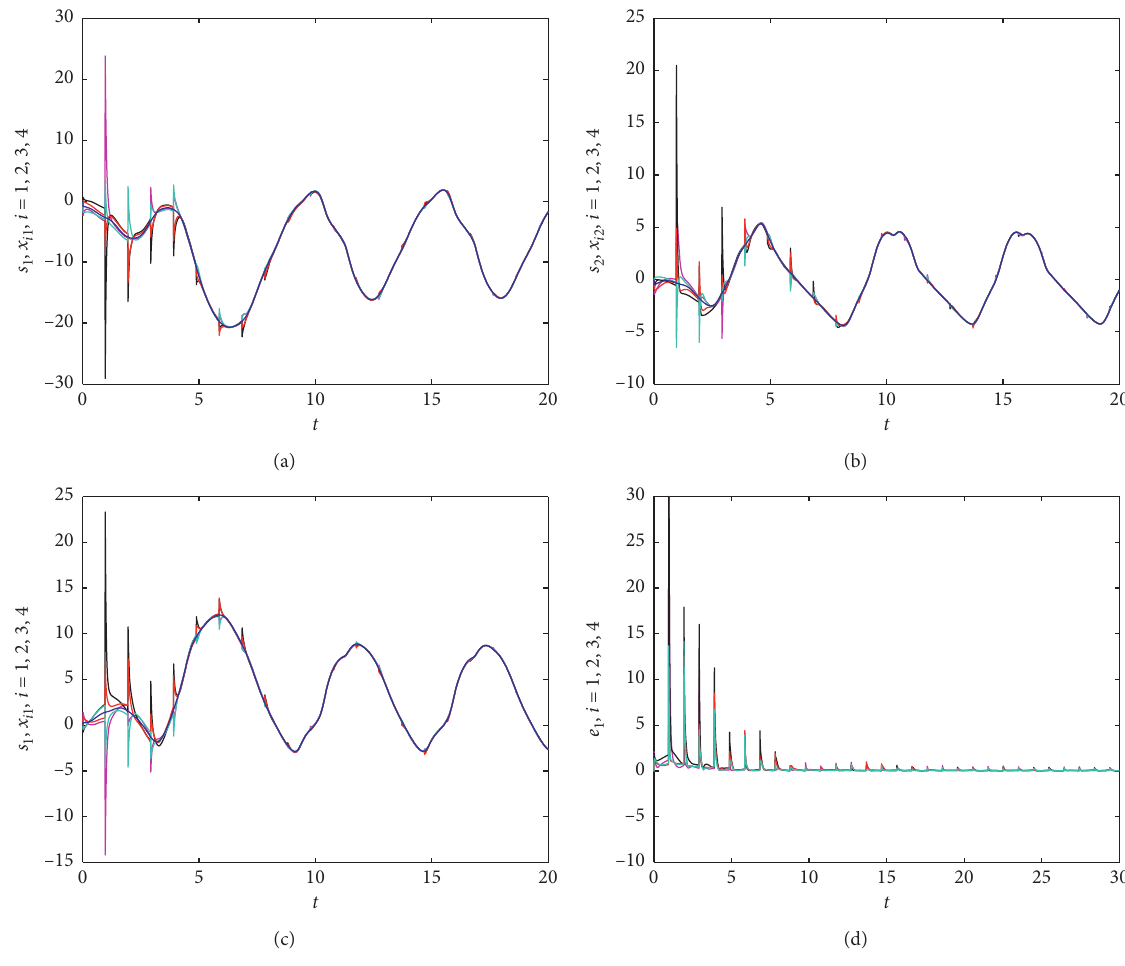
Figure 7: Trajectories with control input for Example